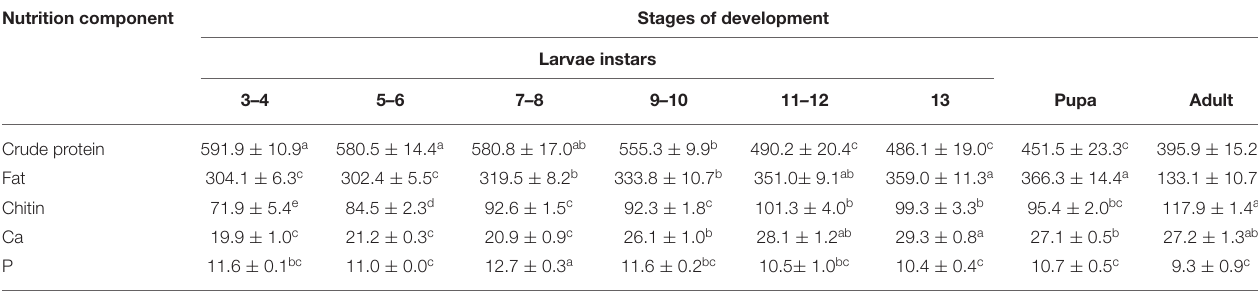
TABLE 1 | Proximate analysis of Tenebrio molitor on a dry basis (mg/g, mean ± SD). Nutrition